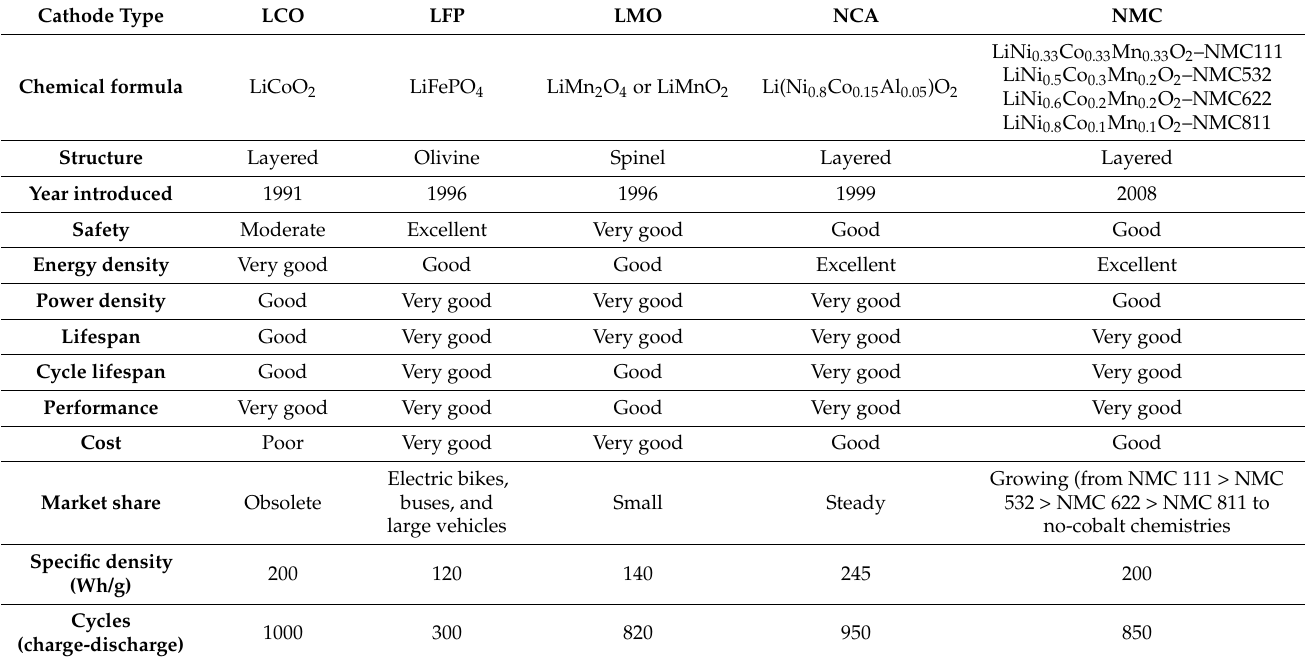
Table 1. Summary of chemistries and characteristics of Li-ion batteries